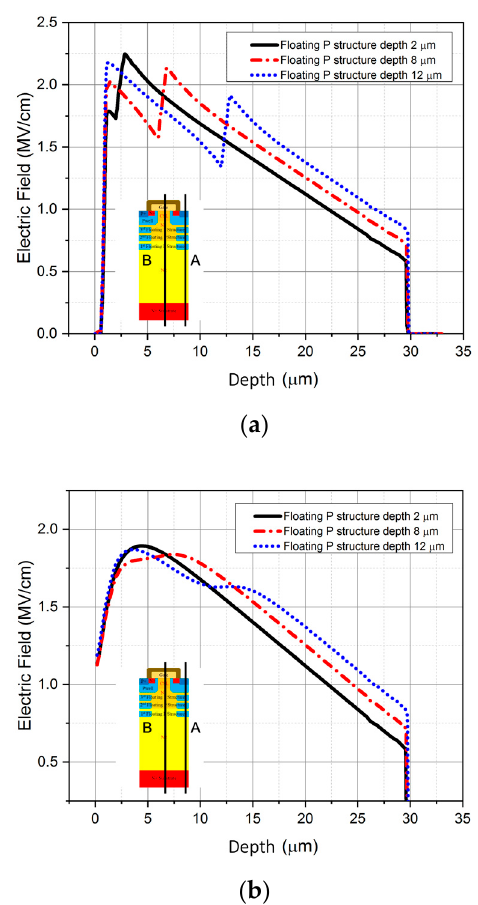
Figure 3. The electric field distribution of different floating P-type structure depths ( a ) in the P-well region and the floating P-type structure area, ( b ) in the drift region of the MOSFET.